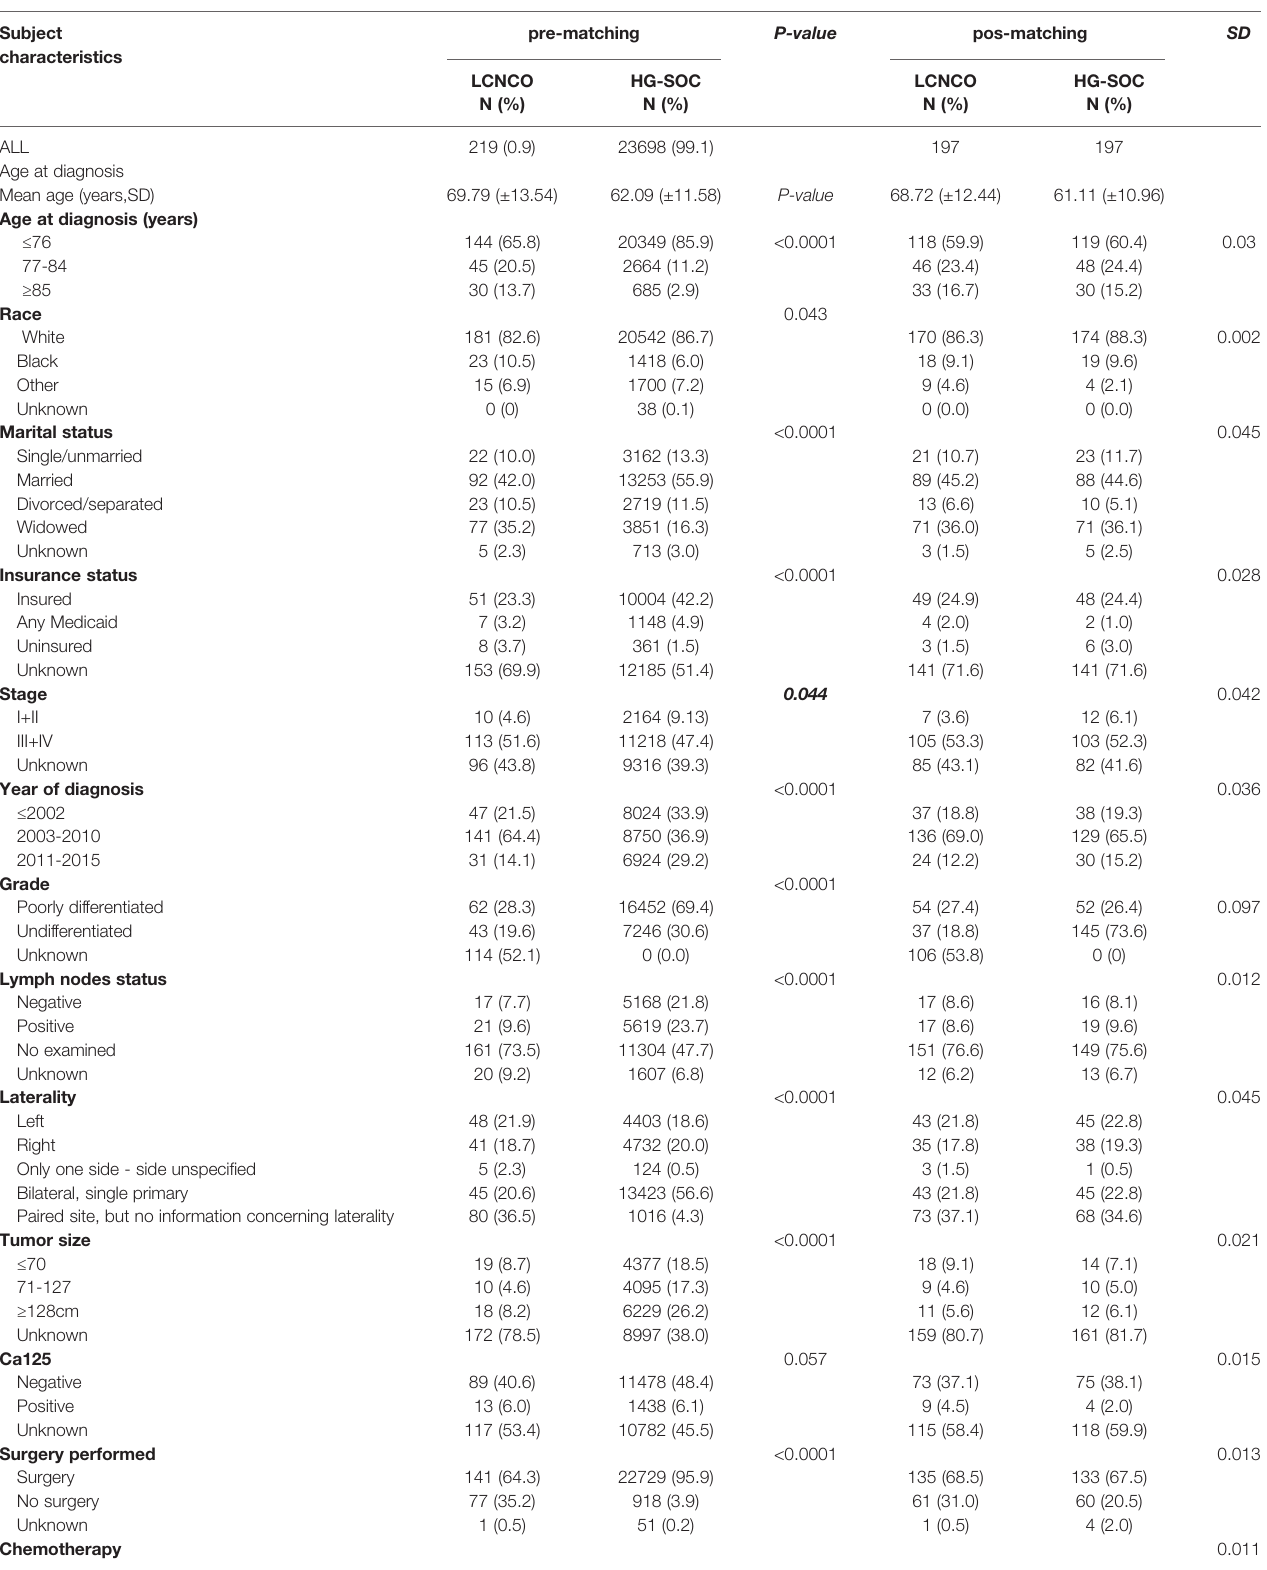
TABLE 1 | Demographic and clinical characteristics comparing LCNEO and HG-SOC (pre-matching and